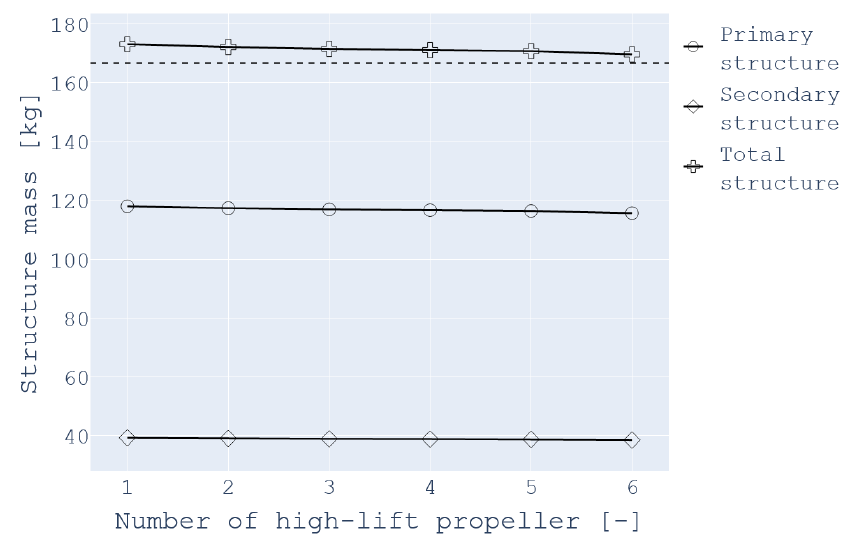
Figure 6. Effect of the number of engines on the overall wing